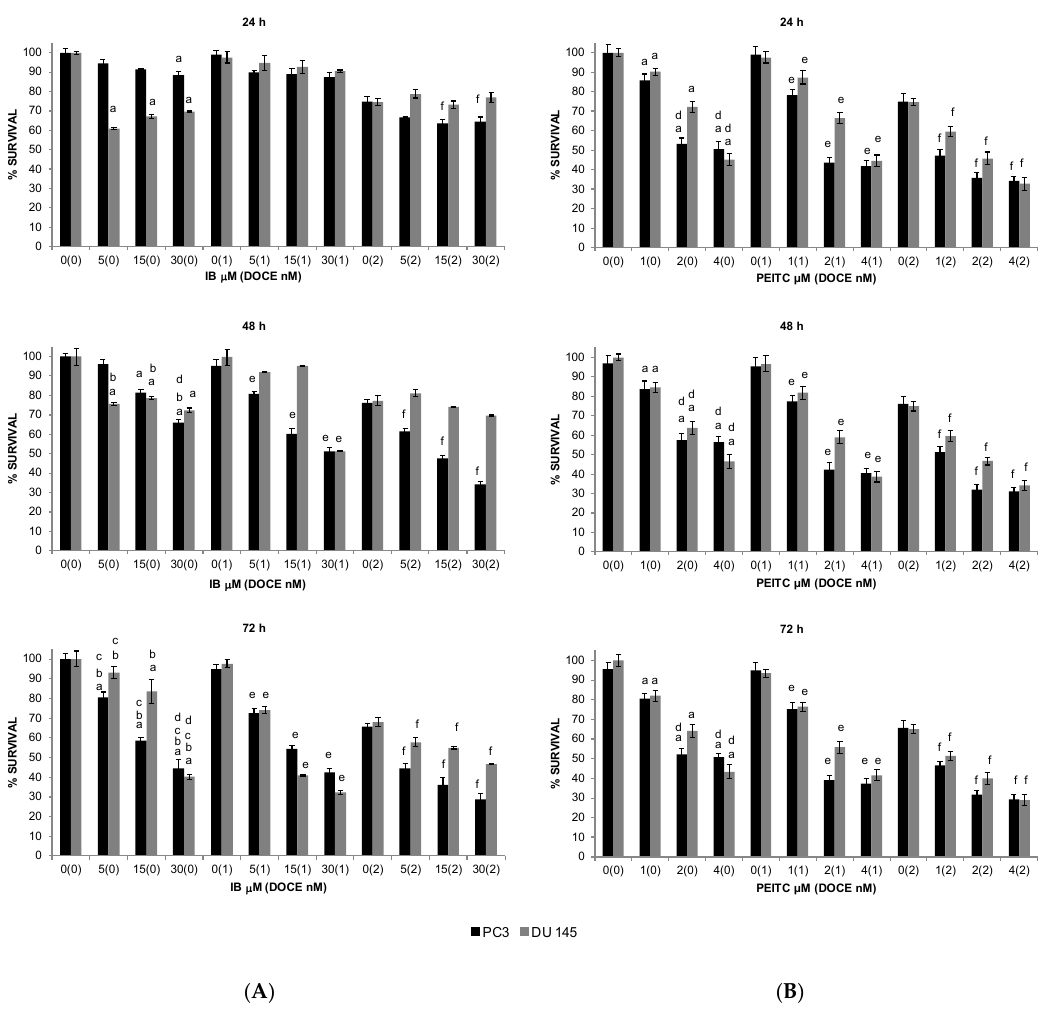
Figure 2. Time-course and dose-response of iberin ( A ) and phenethyl-isothiocyanate ( B ) treatment e ff ects on proliferation of PC-3 (black pillar) and DU 145 (grey pillar) cells as determined by trypan blue dye exclusion assay. Prostate cancer cells were plated, allowed to attach overnight, and treated with DMSO (control) or desired concentration of iberin (IB), phenethyl ‐ isothiocyanate (PEITC) and/or docetaxel (DOCE) for specified time intervals. Both floating and adherent cells were collected and used for counting of dead and live cells. Data are shown as the mean ± SD of three independent experiments. a , p < 0.05, ITC treatment alone significantly different compared with control treatment; b , p < 0.05 , ITC treatment alone for 48 or 72 h significantly di ff erent compared with ITC treatment alone for 24 h; c , p < 0.05, ITC treatment alone for 72 h significantly different compared with ITC treatment alone for 48 h; d , p < 0.05, ITC treatment alone significantly different compared with 2 nM DOCE alone; e , p < 0.05, combination treatment (ITC + DOCE 1nM) significantly different compared with 1 nM DOCE alone; f , p < 0.05, combination treatment (ITC + DOCE 2nM) significantly different compared with 2 nM DOCE alone (one ‐ way ANOVA).